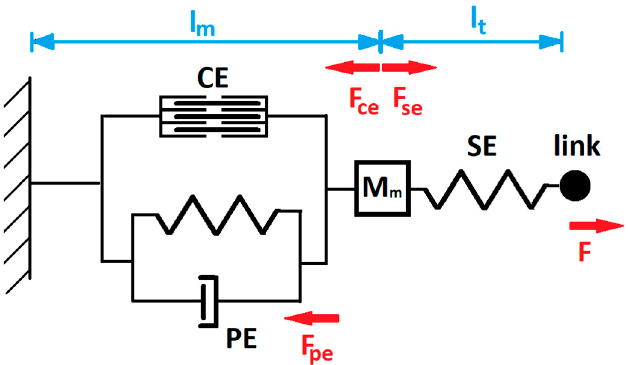
Figure 4. Hill’s muscle